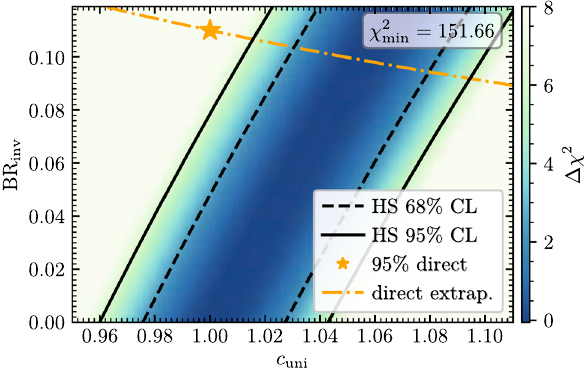
Fig. 2 Result of the global fit to the Higgs boson signal-rate measure- ments assuming a Higgs boson h 125 that has an invisible decay mode and whose couplings to the SM particles are modified w.r.t. the SM predictions by a universal coupling coefficient c uni . The color coding indicates the value of (cid:10)χ 2 resulting from the HiggsSignals anal- ysis. The black solid and dashed lines indicate the allowed regions at the 95% and the 68% confidence level, respectively. The orange star indicates the currently strongest upper limit on BR inv . resulting from direct searches for h 125 → inv obtained according to the assumption that h 125 is produced as predicted in the SM, i.e. c uni = 1 [33]. The orange dashed line indicates an approximate extrapolation of this direct limit for the case c uni (cid:8)= 1 (see text for